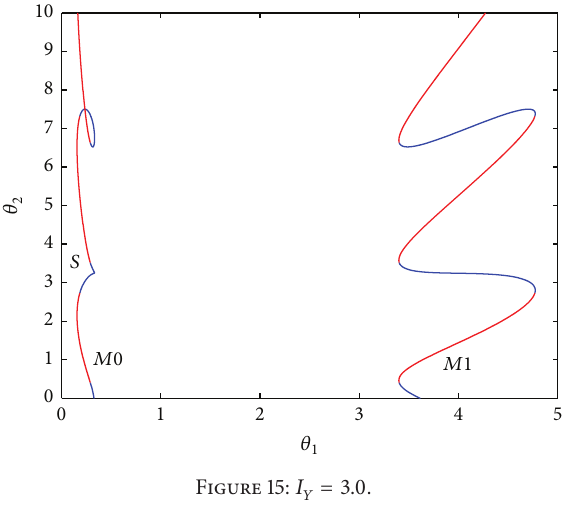
Figure 15: 𝐼 𝑌 = 3.0 . Figure 16: 𝐼